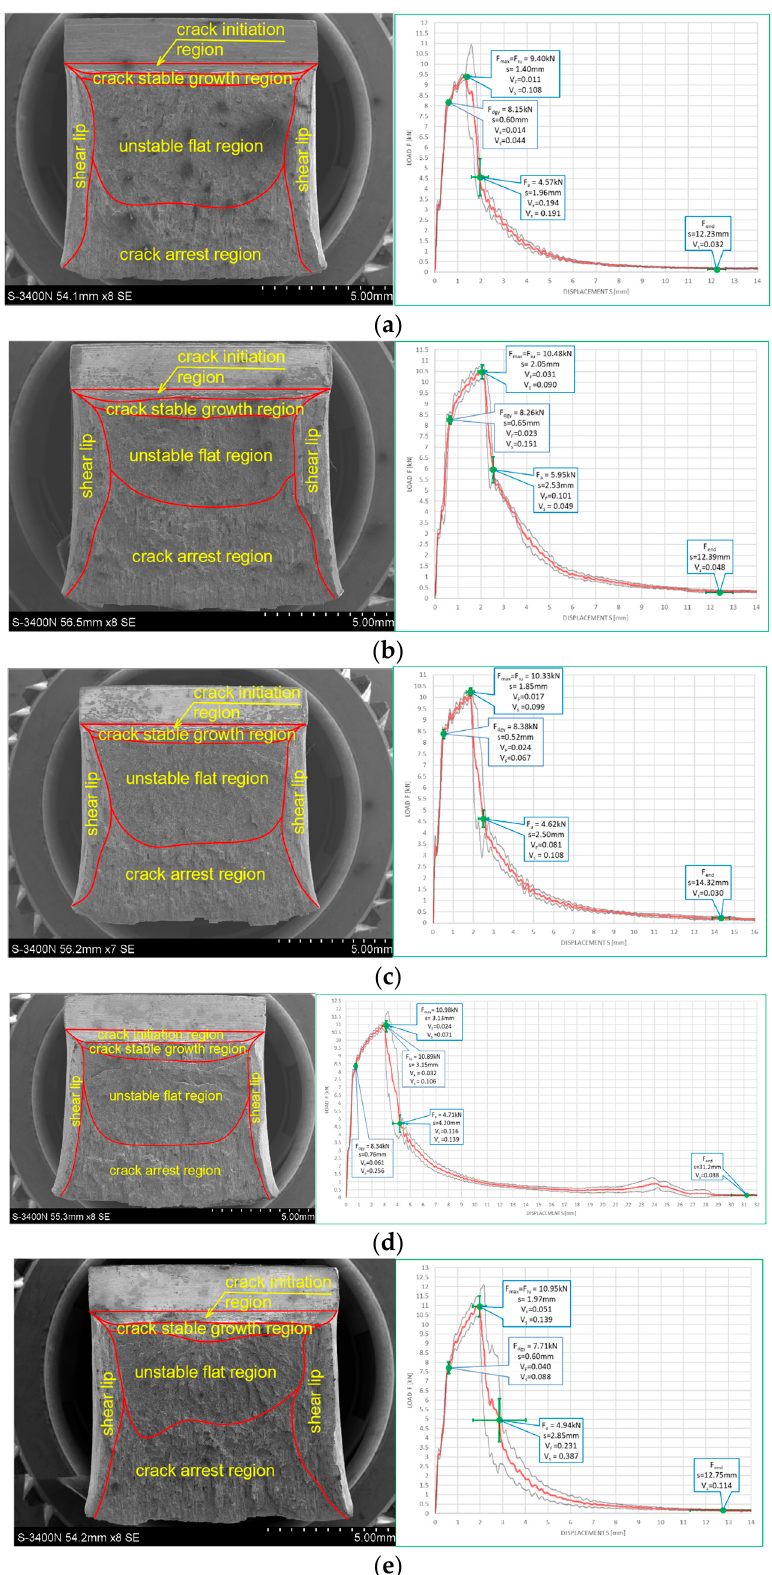
Figure 11. Morphology of the impact fractures obtained during the tests conducted at − 20 °C on the samples made of S355J2+N steel—denotations follow the key listed in Table 1. ( a ) 1 ( − 20) ; ( b ) 160 ( − 20) ; ( c ) 161 ( − 20); ( d ) 180 ( − 20) ; ( e ) 181 ( − 20) .